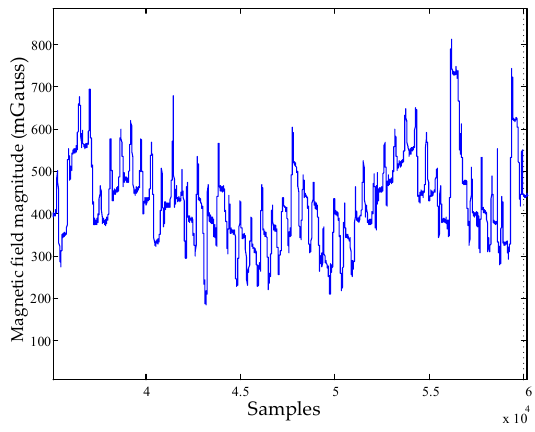
Figure 3. The magnitude of the total magnetic field in indoor environment.